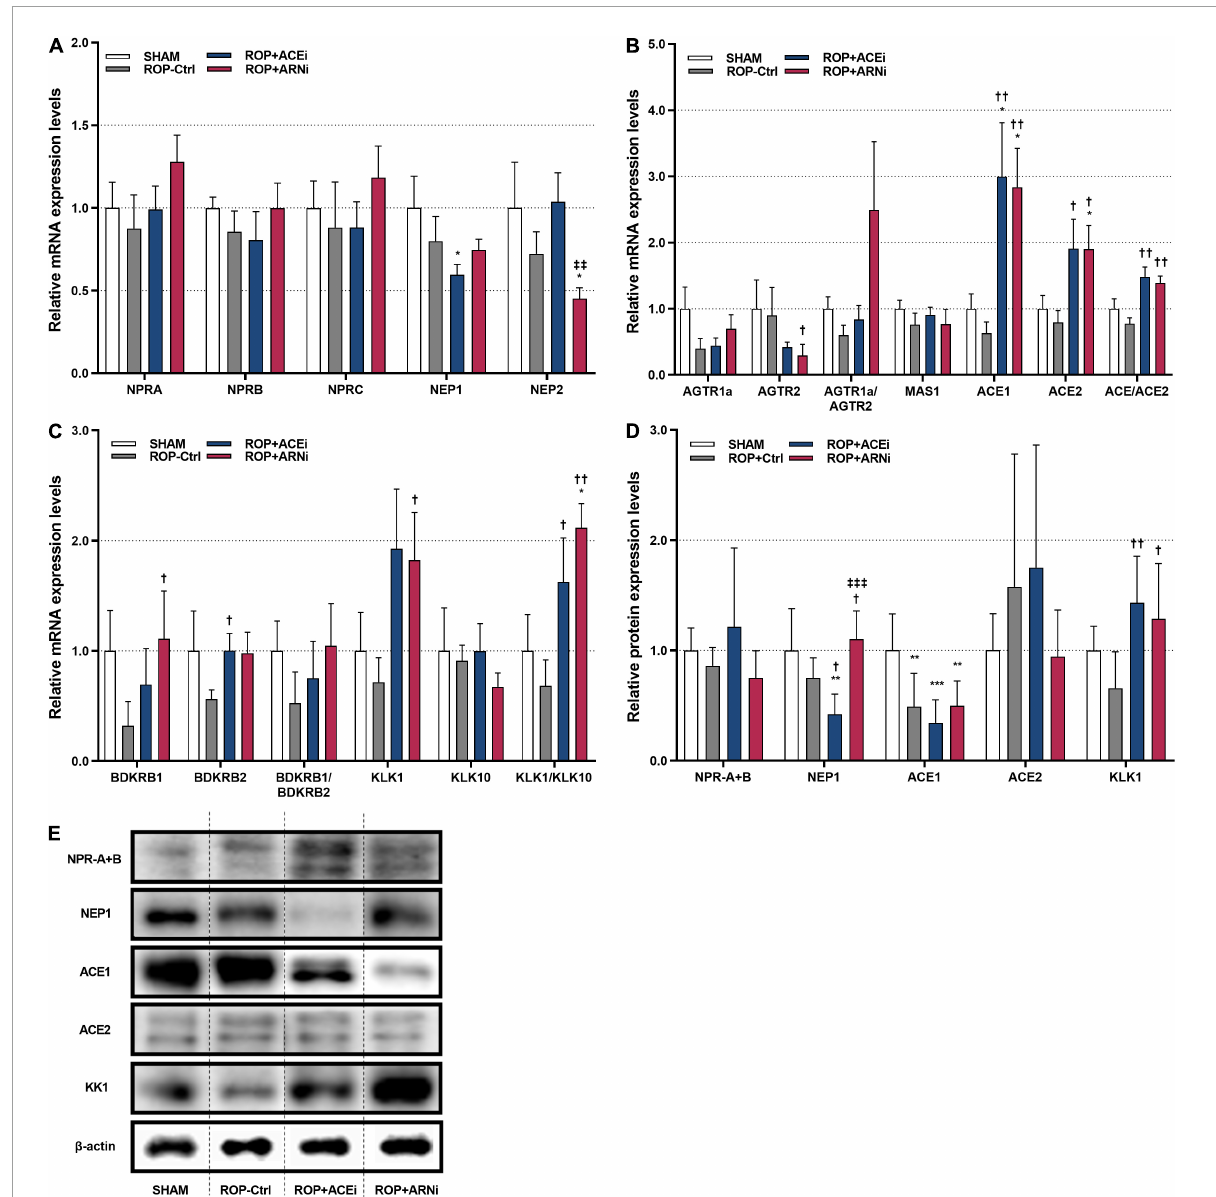
FIGURE4 Molecular and biochemical quantification of target molecules of NPS, RAAS, and KKS. (A) Relative mRNA expression levels of membrane receptors and key enzymes in NPS. (B) Relative mRNA expression levels of membrane receptors and key enzymes in RAAS. (C) Relative mRNA expression levels of membrane receptors and key enzymes in KKS. (D,E) Relative protein expression levels of target molecules. (A–C) Data were given as mean ± standard error of the mean (SEM) and presented here as 2 - (cid:49) CT values and normalized against SHAM. * P ≤ 0.05, ** P ≤ 0.01, *** P ≤ 0.001, compared to SHAM. † P ≤ 0.05, †† P ≤ 0.01, compared to ROP-Ctrl. ‡‡ P ≤ 0.01, ‡‡‡ P ≤ 0.001, compared to